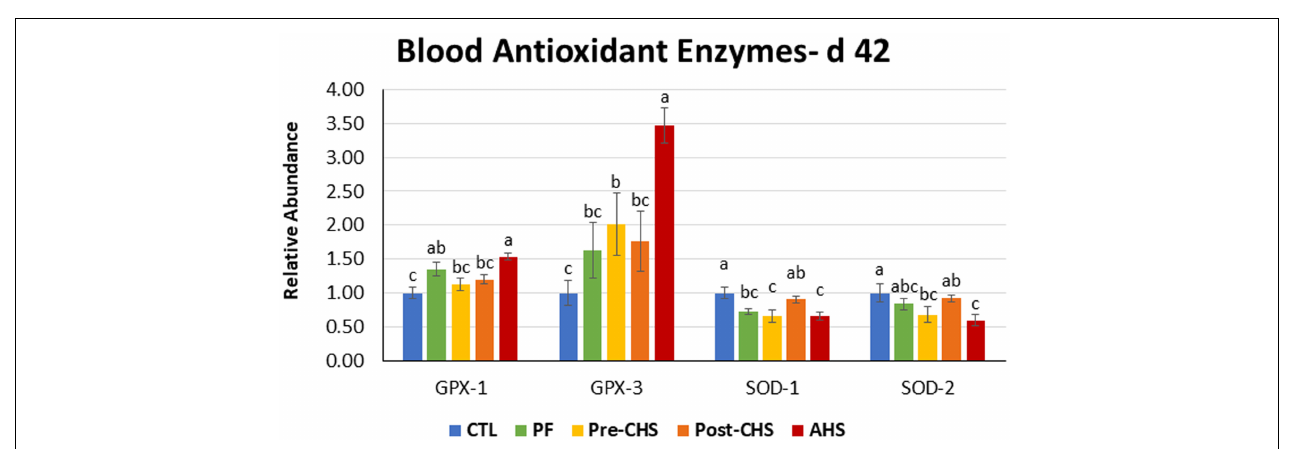
FIGURE 5 | Relative mRNA abundance of superoxide dismutase ( SOD )- 1 , SOD2 , glutathione peroxidase ( GPX )- 1 , and GPX2 in the blood of Cobb 500 male broiler chickens on day 42. Birds in all the groups were raised under the recommended conditions from day 0 to 28. Treatments include: (1) control (CTL): birds raised under thermoneutral condition (23 ◦ C) from day 29 to 42; (2) AHS: birds raised under thermoneutral condition (23 ◦ C) from day 29 to 42, but exposed to 2 h AHS (35 ◦ C) before sampling on day 42; (3) Pre-CHS: birds exposed to high ambient temperature (35 ◦ C) for 8 h/day (9:30 am–5:30 pm) from day 29 to 42, and